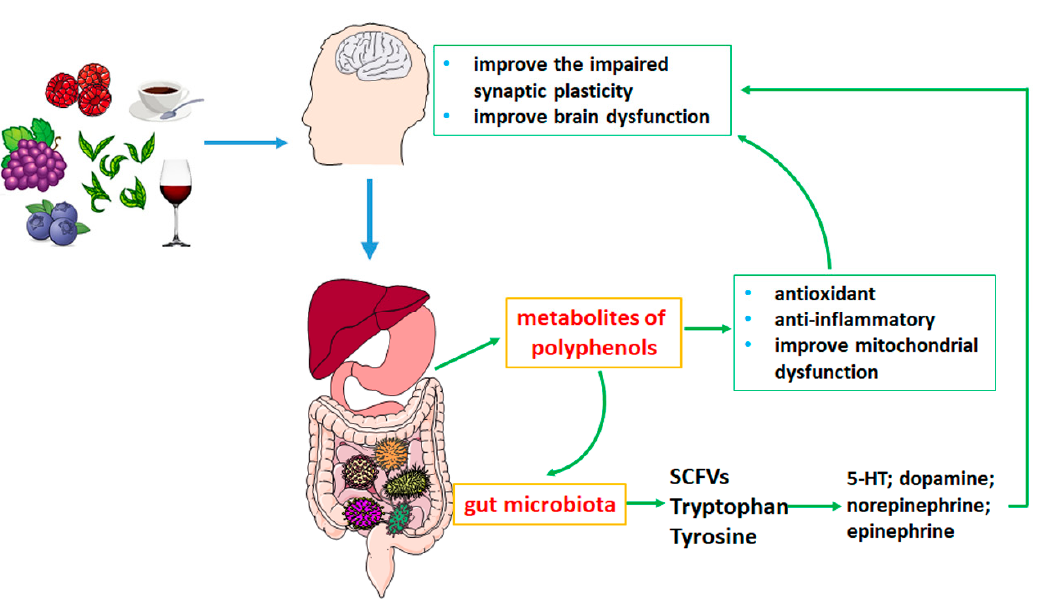
Figure 1. Effects of polyphenols on neurodegenerative diseases by gut microbiota metabolism.